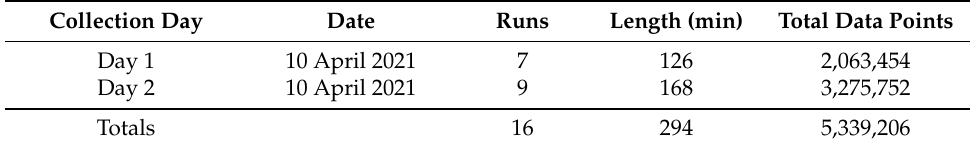
Table 1. Data collection days and total collection